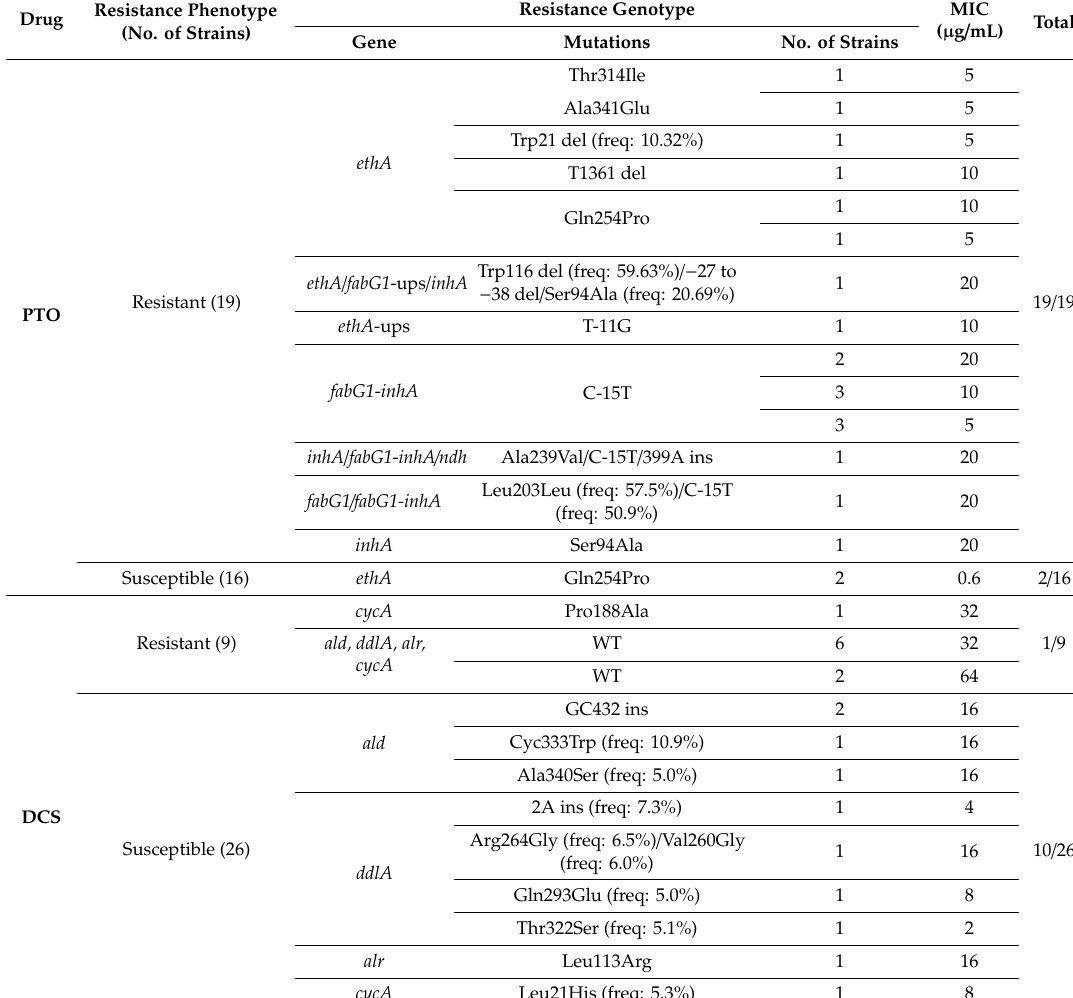
Drug Resistance Phenotype (No. of